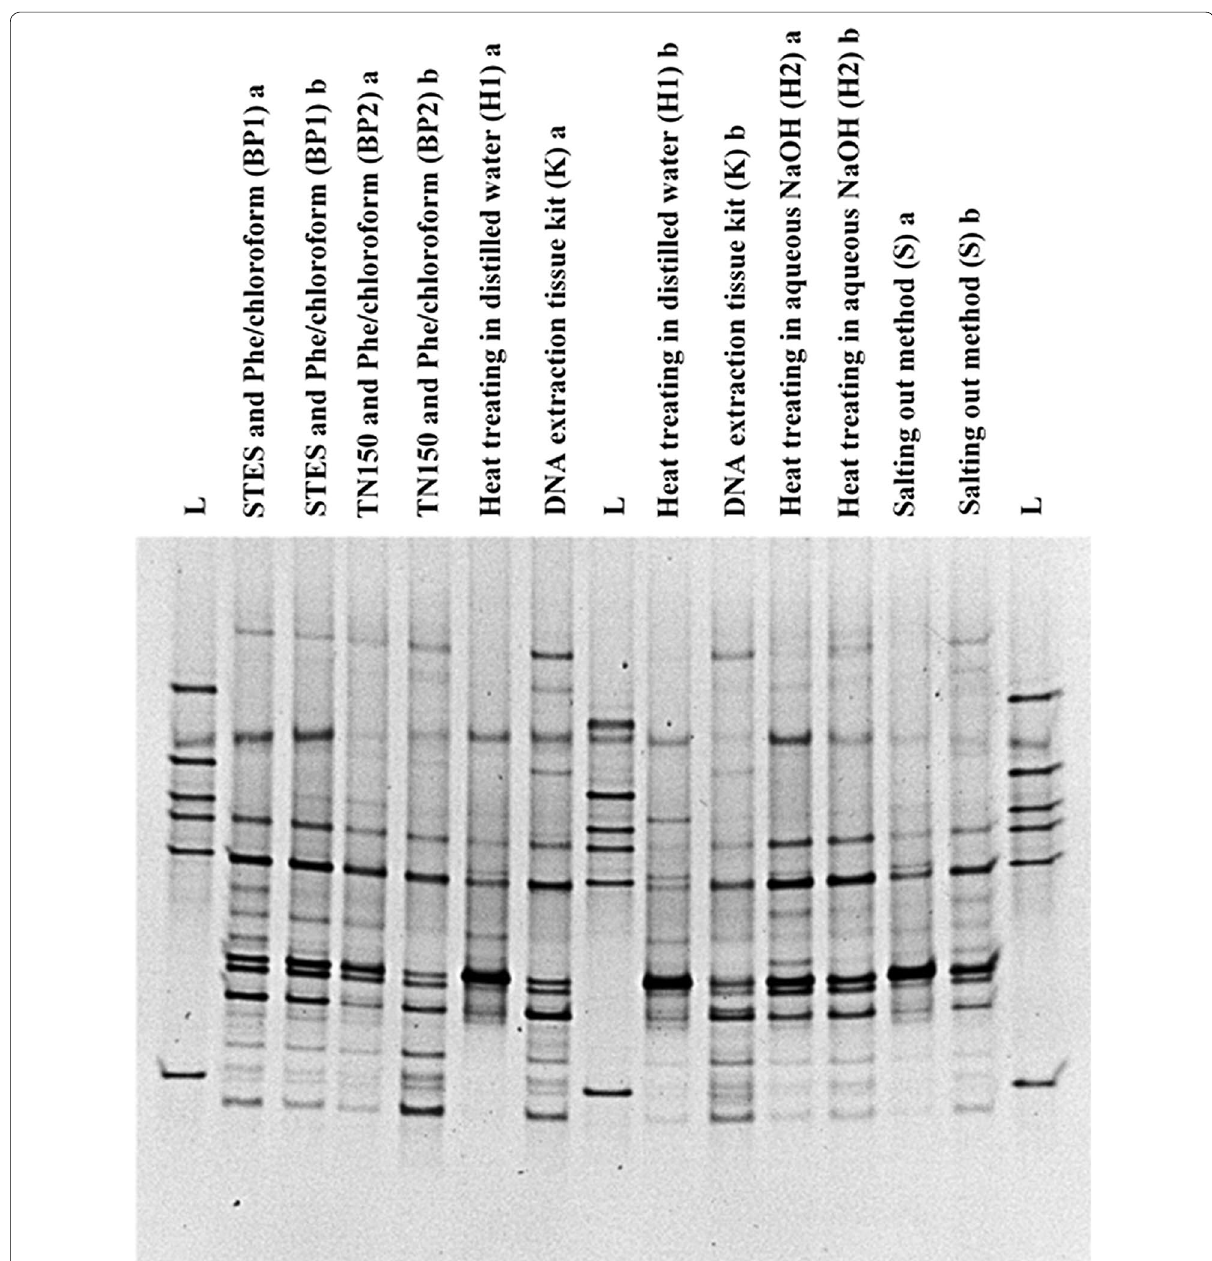
Fig. 3 A comparison of DGGE profiles of PCR amplified bacterial 16S rRNA gene for the specimen No: 1. DNA was extracted using six different DNA extraction methods using 25 mg of wound tissue debridement specimen no. 1. Bacterial fingerprinting profile is based on 30–55% denaturing gradient. “L” lanes represent the in house bacterial reference panel which includes S. aureus, Acinetobacter spp, Group B Streptococcus spp., E. faecalis , Group A Streptococcus spp. and E. coli from top to bottom respectively. Other lanes show bacterial fingerprinting profile of each extraction method in duplicate ( a , b ) for the specimen No. 1, collected from a subject with a chronic